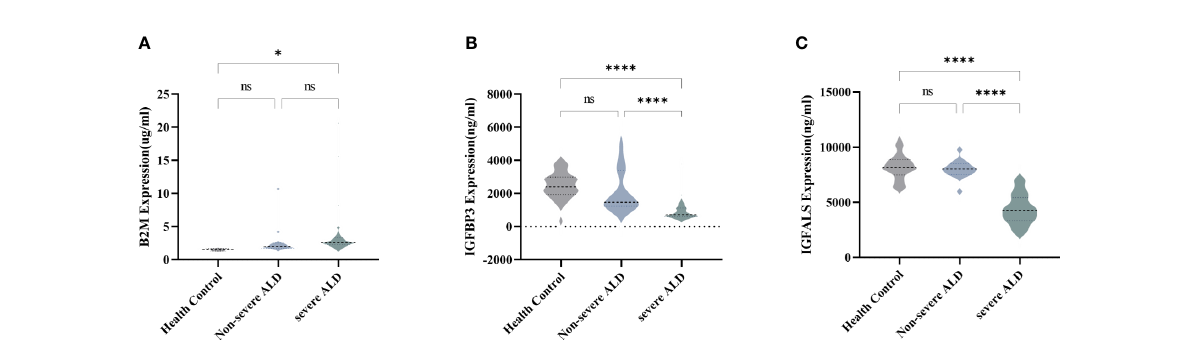
FIGURE 2 Serum concentration of B2M, IGFBP3, and IGFALS in different stages of ALD patients. (A) Serum concentration of B2M in HC group, non-severe ALD group, and severe ALD group. (B) Serum concentration of IGFBP3 in HC group, non-severe ALD group, and severe ALD group. (C) Serum concentration of IGFALS in HC group, non-severe ALD group, and severe ALD group. ns is P >0.05; * P <0.05; **** P